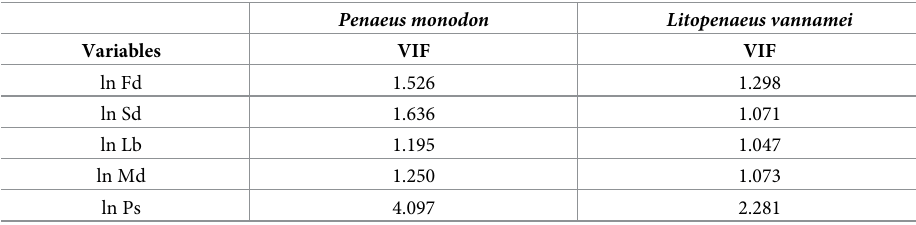
Table 8. Variance inflation factor (VIF) analysis for multicollinearity.